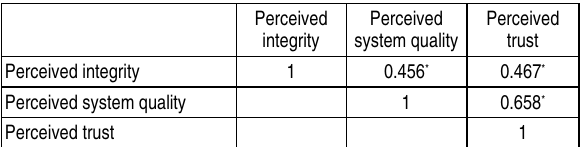
Table 3. Relationship between perceived integrity, perceived system quality and perceived trust